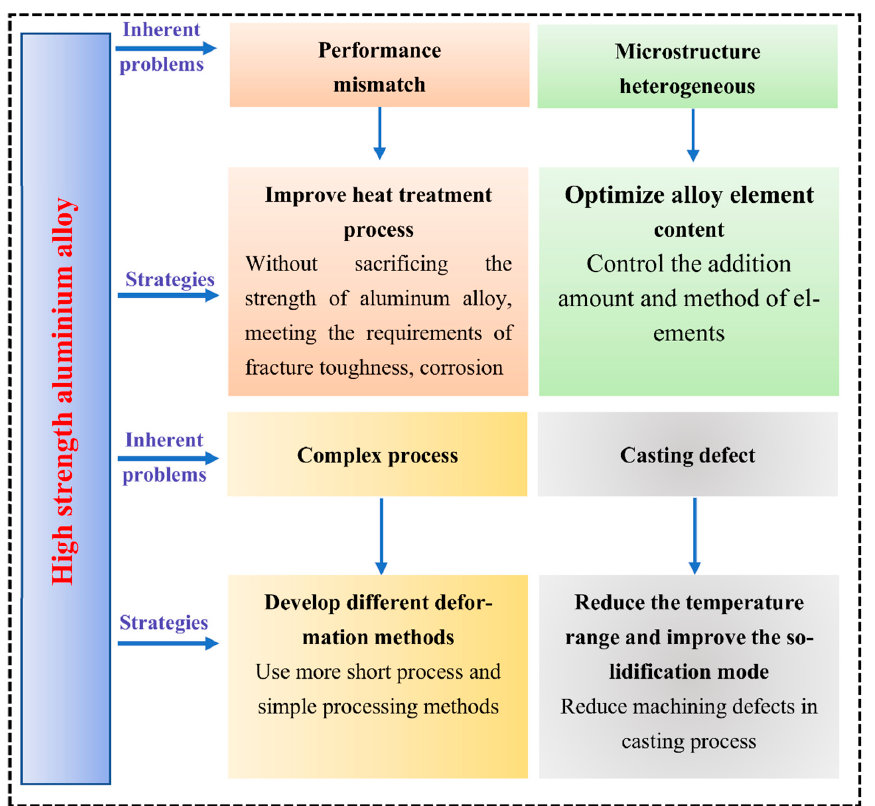
Figure 4. Inherent problems with and solution strategies for high-strength aluminum alloys.